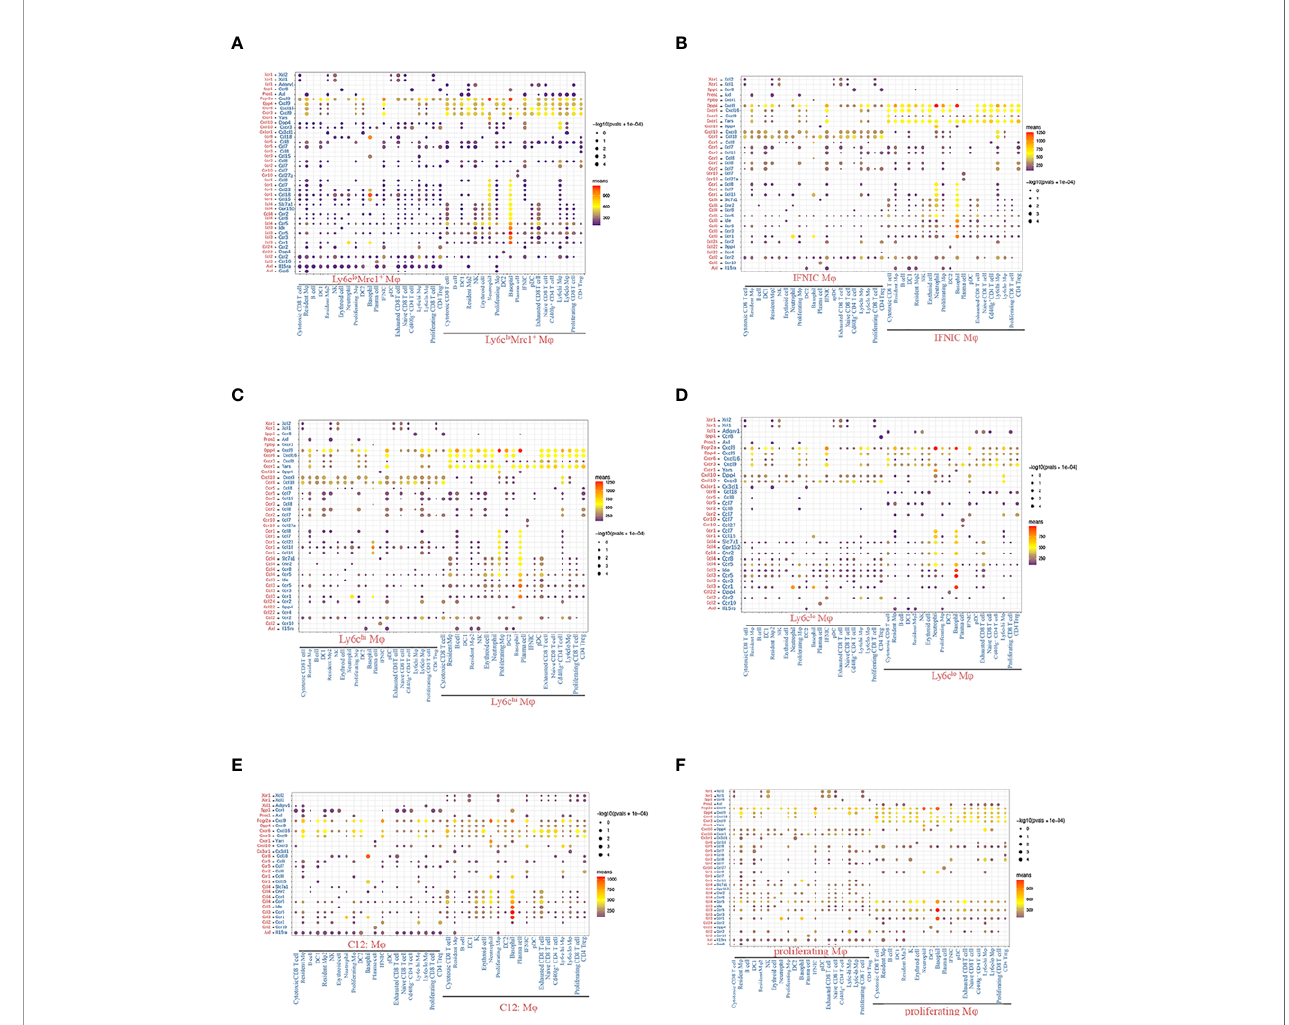
FIGURE 12 | Chemokine mediated LR interactions between macrophages and other immune cell clusters. (A – F) Overview of chemokine mediated LR interactions between macrophages and other immune cell clusters. P values are indicated by circle size, with the scale to the right (permutation test). The means of the average expression levels of interacting molecule 1 in cluster 1 and interacting molecule 2 in cluster 2 are indicated by color. Assays were carried out at the mRNA level but were used to extrapolate protein interactions. Only LR pairs with means value >100 are shown. M j , macrophage; DC, dendritic cells; pDC, plasmacytoid dendritic cell; IFNIC, IFNg induced cells; LR, ligand and